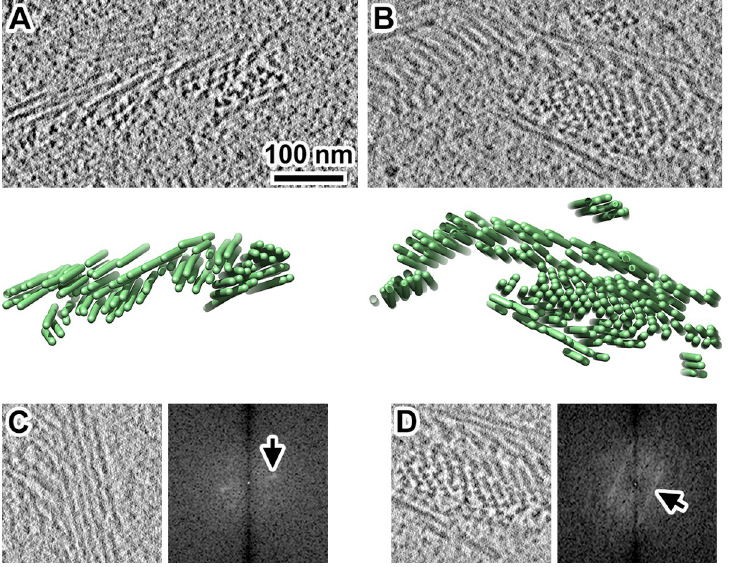
Fig 6. Yeast MTHs form ordered bundles. (A and B) Upper: Volta cryotomographic slices (10 nm; computational) of WT cells that were frozen after a 4-hour incubation in SM. Lower: 3-D models of the distribution of MTH bundles. Each MTH is rendered as a tube. (C and D) Volta cryotomographic slices (left, 10 nm; computational) and power spectra (right), taken at regions with many MTHs. Panel D shows the same MTH bundle as panel B, but from a different position along the Z axis. Arrows point to elongated peaks in the power spectra, which correspond to approximately (C) 14 nm and (D) 22 nm spacings.